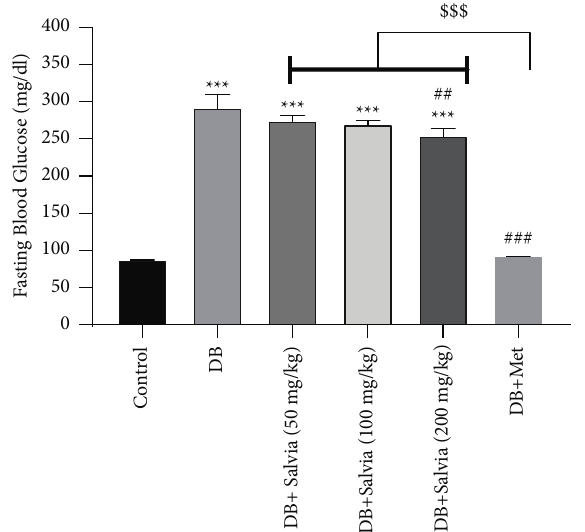
Figure 1: Effect of Salvia spinosa extracts on fasting blood glucose concentrations in streptozotocin-induced diabetic mice. Control: normal mice, DB: diabetic mice, DB+Salvia: diabetic mice given the methanolic extract of Salvia spinosa , and DB+Met: diabetic mice given metformin (500mg/kg). Values represented as mean ± SD. ∗∗∗ P < 0 . 001 compared with control mice, ## P < 0 . 01 compared with diabetic mice. ### P < 0 . 001 compared with diabetic mice. $$$ P < 0 . 05 compared with metformin-treated diabetic mice.